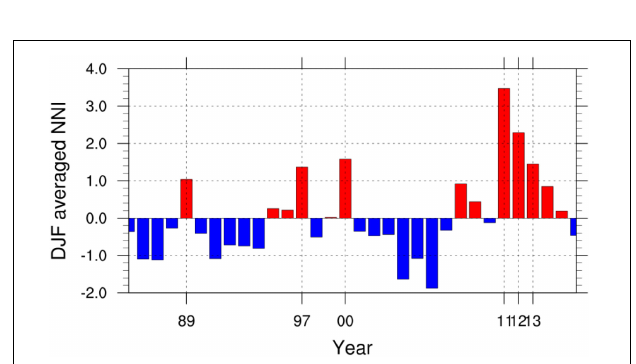
FIGURE 5 | Climatological seasonal cycle of latent heat flux (into the atmosphere) over the region (110 ◦ E-116 ◦ E, 22 ◦ S-32 ◦ S) from (A) EX-wspd, (B) EX-sst, (C) EX-qa.